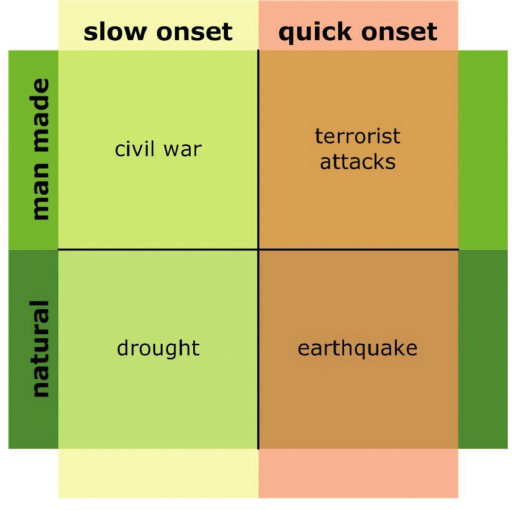
Figure 1: Schema for classification of disastrous events (Adapted from Viljoen,